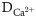
Network-wide astrocytic Ca2+ response to light stimulation.A 10-by-10 network of astrocytes was employed to analyze the response of cells when the central 4-by-4 astrocytes (white square in heatmaps of panels A and C) were stimulated (◊: T = 4 s, δ = 45% (1.8 s), 45 min). See the network organization schematic in Fig 1. Simulations were conducted in the presence (left panel) and absence (right panel) of Ca2+ buffering with varying gap junctional Ca2+ coupling coefficient (DCa2+). A symmetric 2D Gaussian fit was utilized to quantify the response, i.e., peak and magnitude of the spread from the stimulated region. A) Heat maps of network-wide light stimulation-induced Ca2+ basal levels. B) Plots of the peak basal level and σbasal-level obtained from the Gaussian fit with varying DCa2+ values. Vertical dashed grey line denotes the DCa2+ value used to generate the heat maps in panels A and C. C) Heat maps of network-wide spiking rate response corresponding to basal levels in panel A. For spike classification, a threshold of 0.2 μM above the basal level was selected. D) Plots for the peak spiking rate and σspiking rate with varying DCa2+ values.